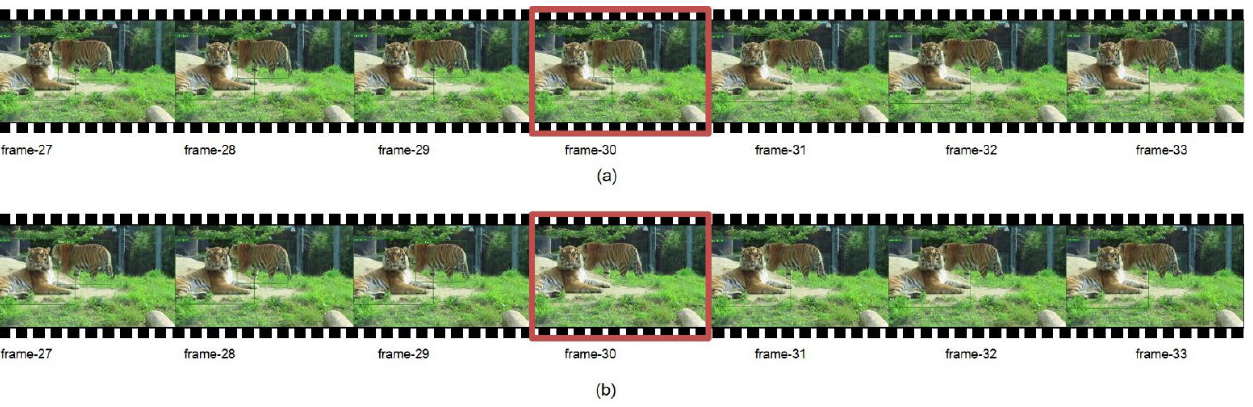
12 of 16 Figure 9. Tracking example of a golden snub-nosed monkey. 3.4. Ablation Study and Discussion Here, we discuss the impact of the three parts of the three-stage matching and elastic-